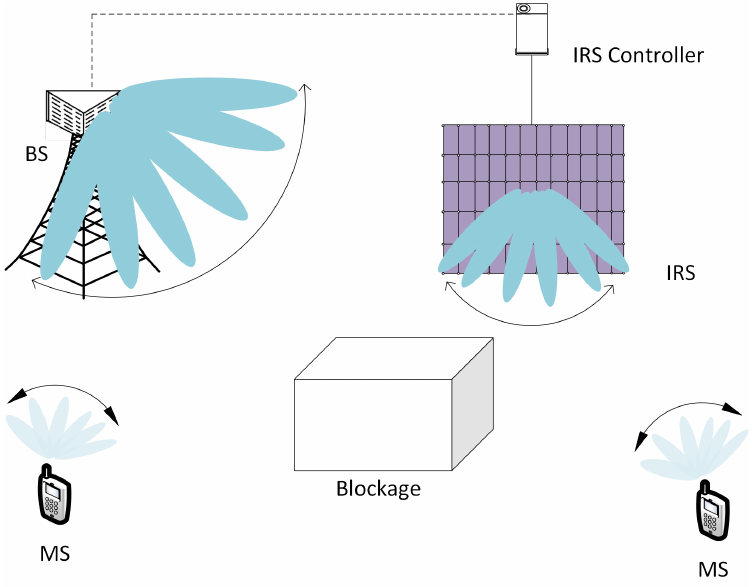
Figure 1. Beam training for an IRS-assisted cellular